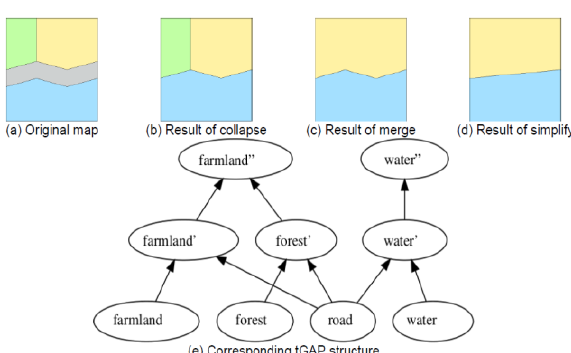
Fig. 3. Structure of variable-scale model; a) tGAP hierarchical tree for semantic information and imp value, b) geometry and topology in horizontal slice planes